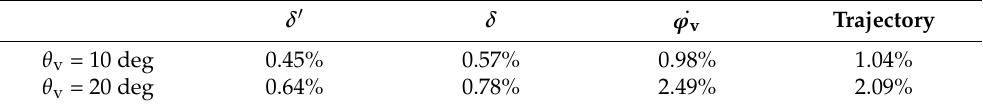
Table 4. The influence of prototype tilting on steering.